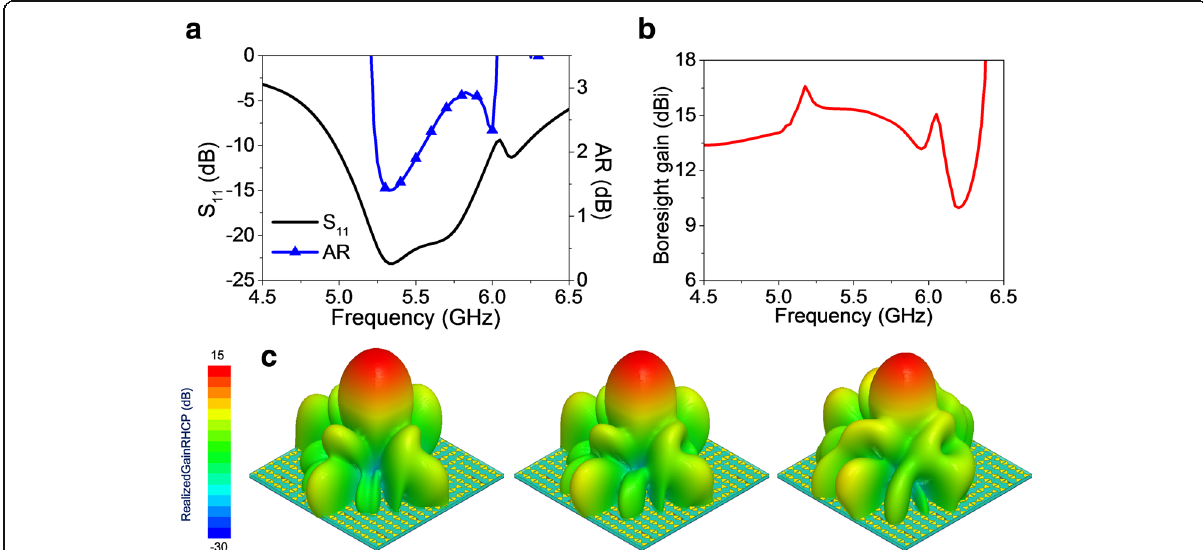
Fig. 7 RHCP radiation properties of the EMMS with “ 0 ” and “ 1 ” fed with equal magnitude and 90° phase shift. a S 11 and AR versus frequency. b Boresight gain versus frequency. c 3D RHCP radiation patterns at 5.35, 5.5, and 5.75 GHz (from left to right)